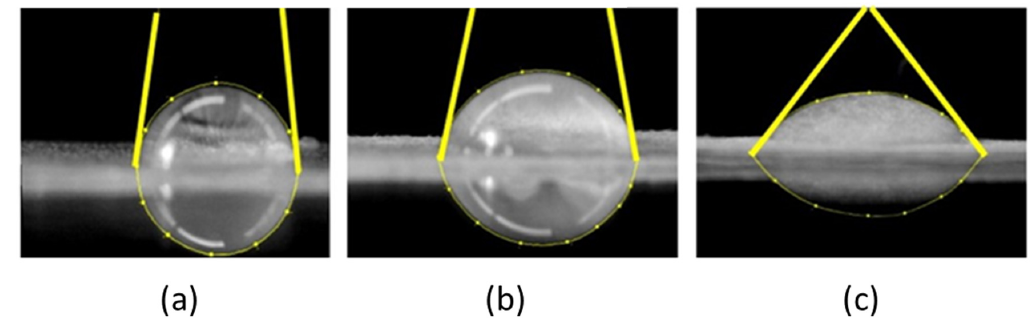
Figure 5. Image analysis (KSV Instruments Ltd.) identification of the droplet contact and circumference points of a droplet on MNFC film derived from 300 min enzymatic fibril pretreatment: ( a ) high contact angle, ( b ) medium contact angle, and ( c ) low contact